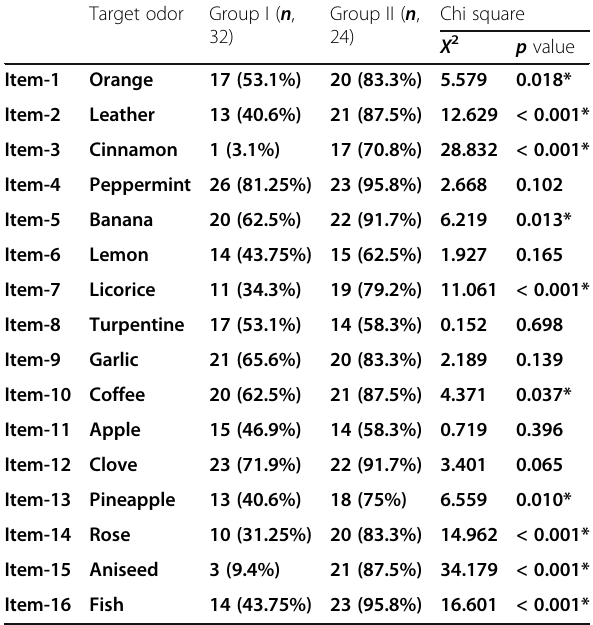
Table 3 Percent of correct responses in the identification Sniffin ’ Sticks subtest among Parkinson disease patients (group I) and healthy control subjects (group